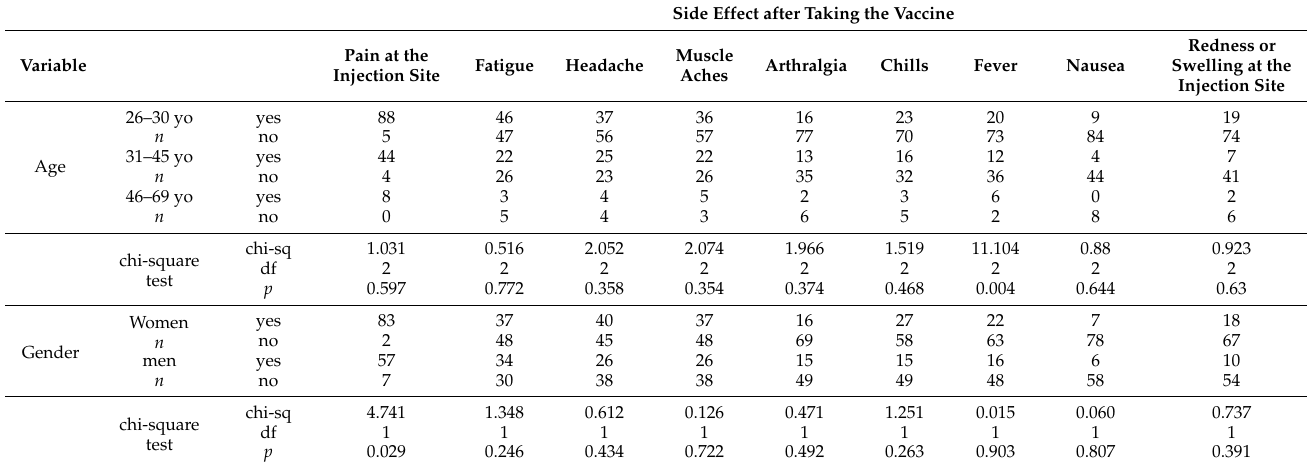
Table 4. Comparison of the number of side effects after taking the vaccine with age and gender. Side Effect after Taking the Vaccine